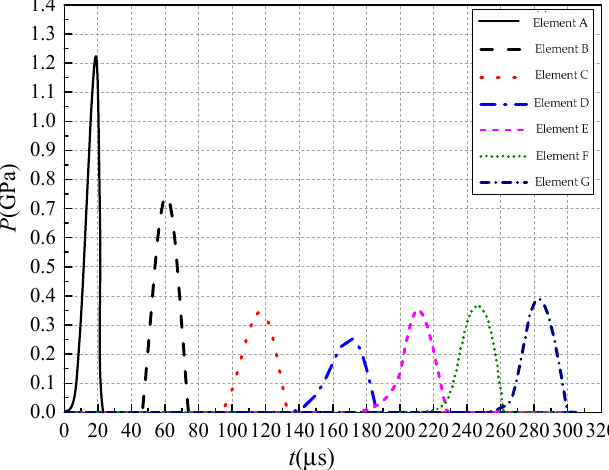
Figure 7. Pressure–time curves from element A to element G.